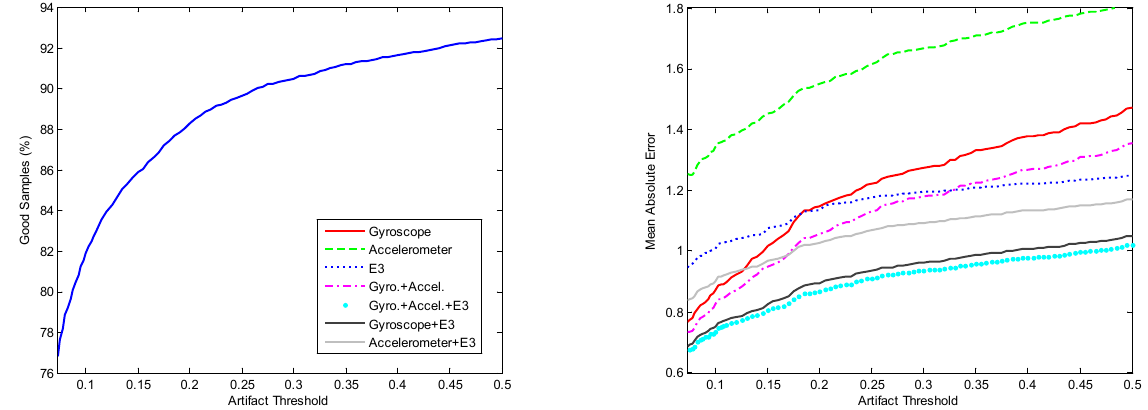
Artifact Threshold